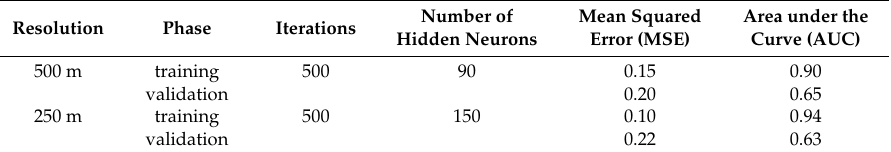
Figure 7. Example of training results generated for 500-m grid cells, comparing mean squared error ( a ) and area under the curve ( b ) against number of radial basis functions calculated for training runs with 500 iterations. The number of input vectors is 94 (70% of dataset) and 40 (30%) for training and validation, respectively. Table 2. Summary of training and validation